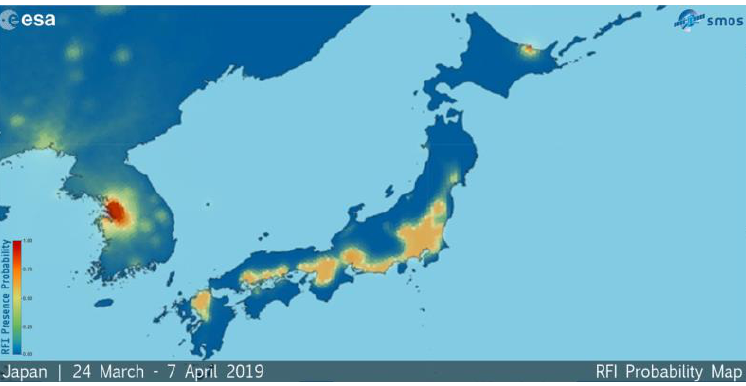
Figure 19. Korea and Japan RFI probability map in April 2019.